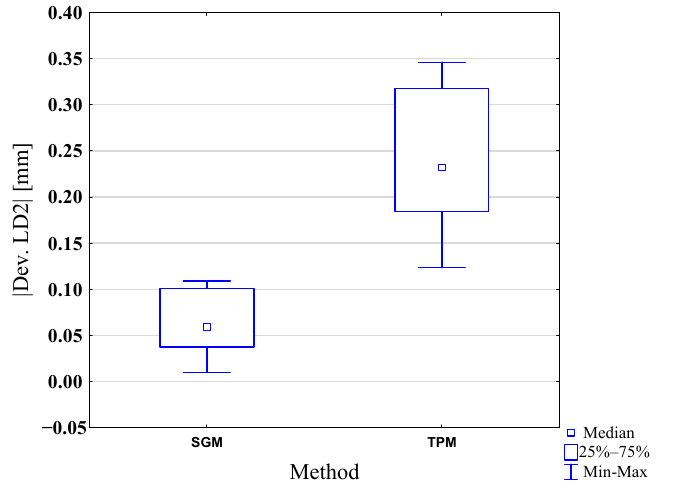
Figure 6. Comparison of the absolute values of the linear dimension 1 deviations for SGM and TPM methods.